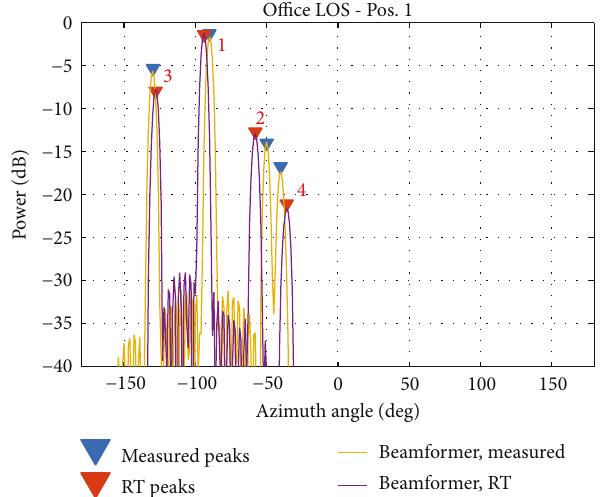
Figure 24: The identi fi ed 4 dominant paths in the measured and RT-simulated channels and the associated multiple beams for Tx position 1 in the o ffi ce scenario.